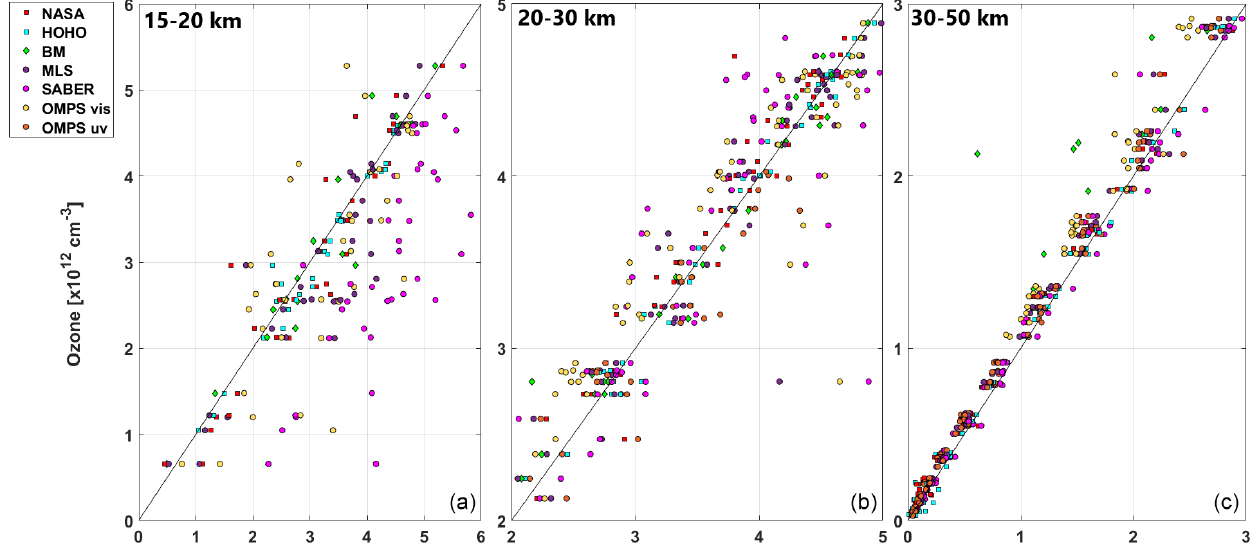
Figure 7. Ozone scatter plots, smoothed using a 2km boxcar average, with respect to ozone number densities from the HOH lidar: (a) 15 to 20km; (b) 20 to 30km; (c) 30 to 50km.